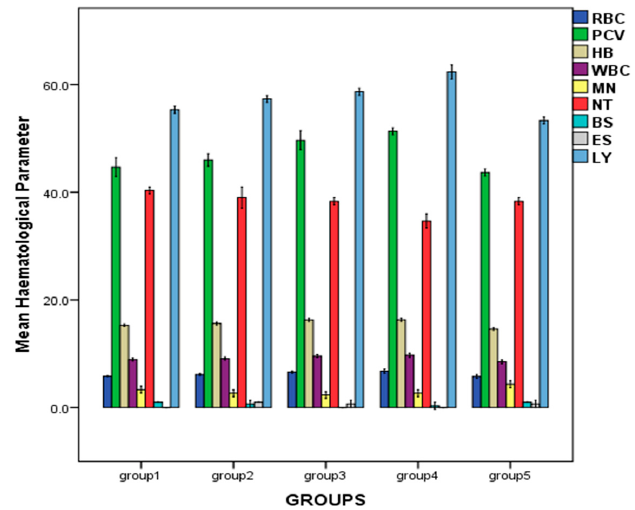
Figure 2. Effect of repeated oral administration of P. dactylifera seed essential oil on hematological